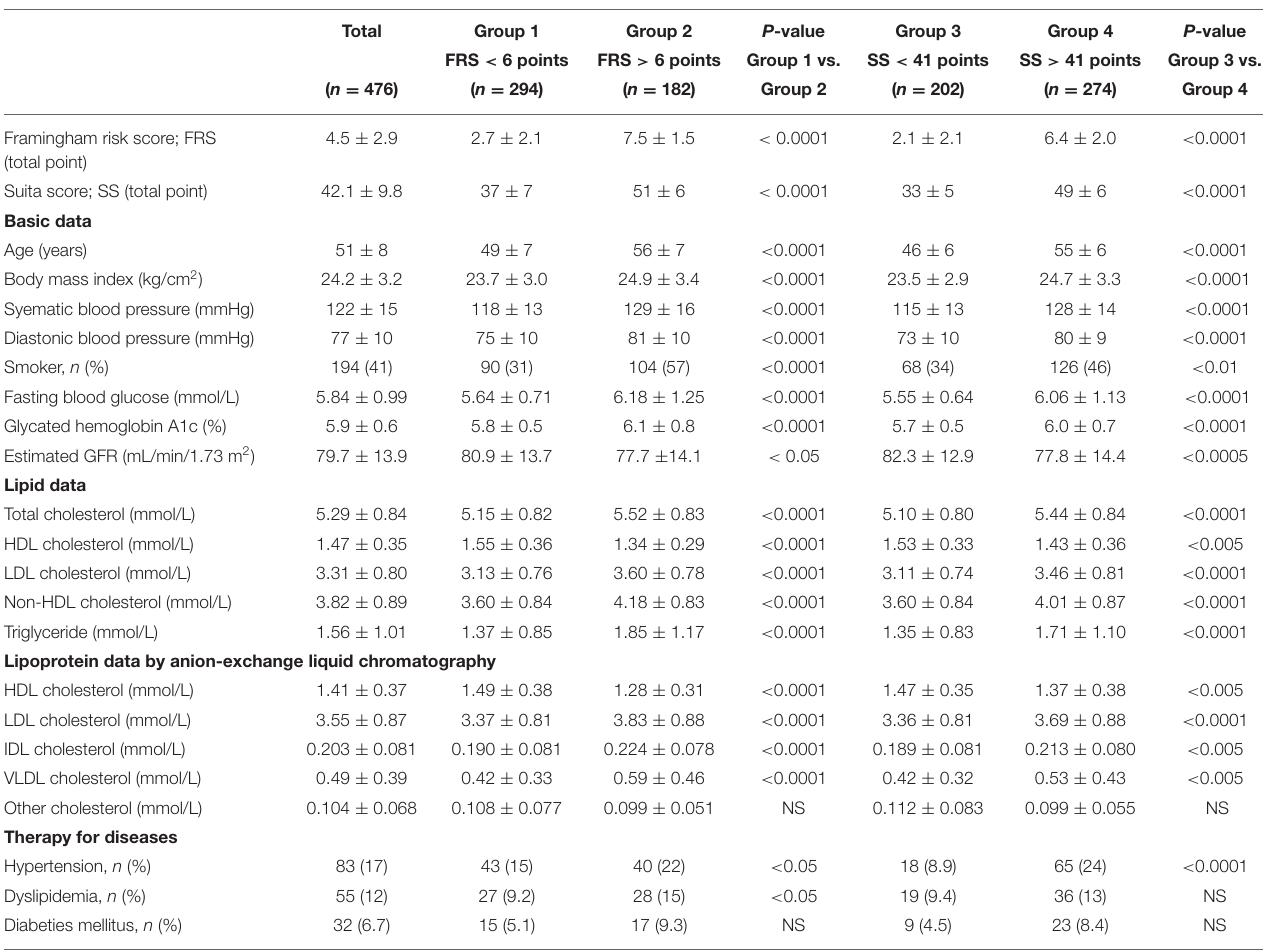
TABLE 1 | Clinical characteristics, biochemical data, Framingham risk score and Suita score of the study subjects.